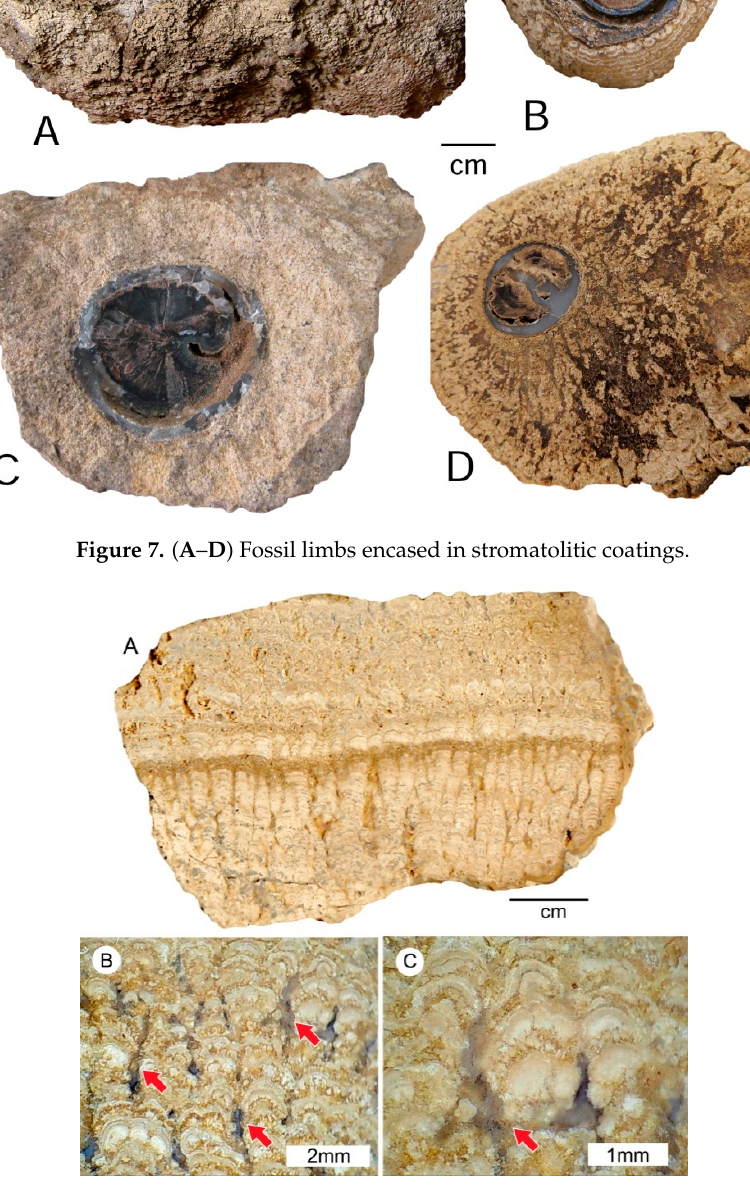
Figure 8. Calcareous stromatolites with chalcedony fillings. ( A ) general view. ( B,C ) Chalcedony-filled zones in are visible in magnified images.